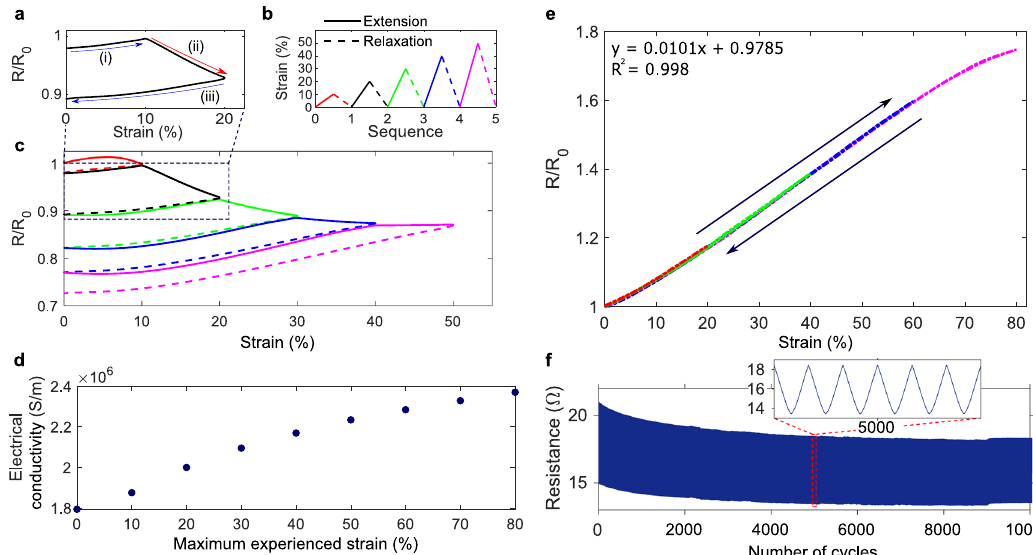
Fig. 4 Electromechanical characterization of LMMN fi lms. a – c Relative resistance response of the LMMN fi lm under incremental cyclic loading. a The second cycle sequence up to 20% strain. (i) Tracing previous curve, (ii) reinforcement of LMMN, and (iii) new strain-resistance curve. b Tensile strain pro fi le, c the entire relative resistance response. d Volumetric electrical conductivity of LMMN fi lms with different values of maximum experienced strain. e The relative resistance versus strain plot of the LMMN fi lm with former strain experience up to 80%. Increasing strain sequence was applied from 20 to 80% during the measurement. f Resistance response of an LMMN fi lm over 10,000 cycles to 50%